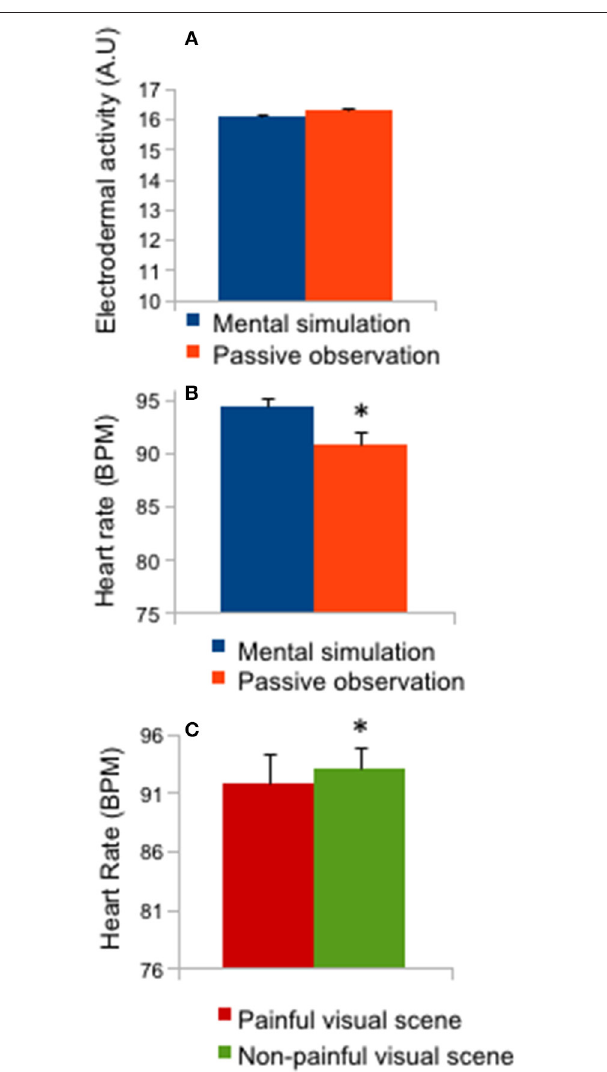
FIGURE 4 | Heart rate and electrodermal activity. (A) Mean ± SD of electrodermal activity (mental simulation vs. passive observation conditions); (B) Mean ± SD of heart rate (mental simulation vs. passive observation conditions); (C) Mean ± SD of heart rate (painful vs. non-painful visual scenes), * p <